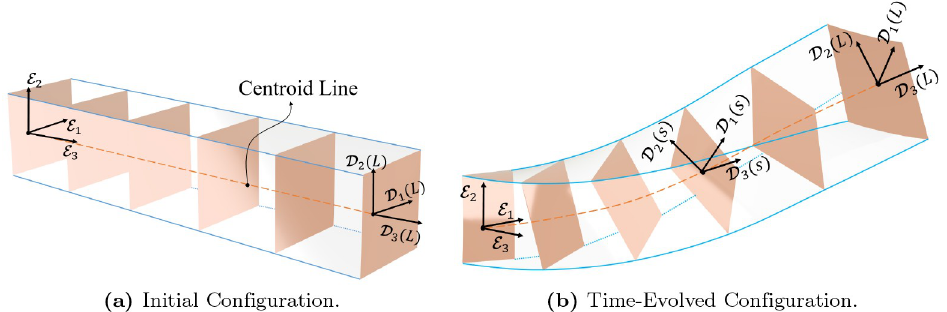
; E ; E g are also shown at the fixed end of the 1 2 3 ; D ; D g are attached to the cross section at the centroid s and the tip of 1 2 3